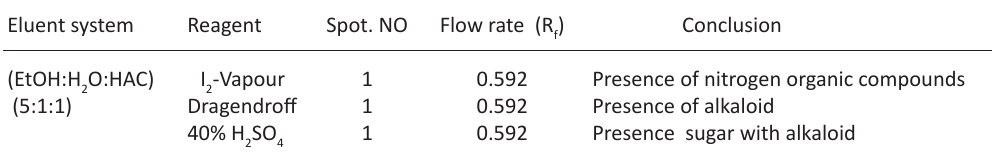
Table 3. Statements the effective groups of alkaloid compound extracted from myristica fragrans